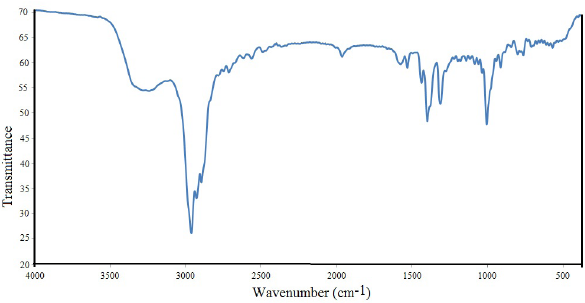
Figure 1: The IR spectrum of compound (3).